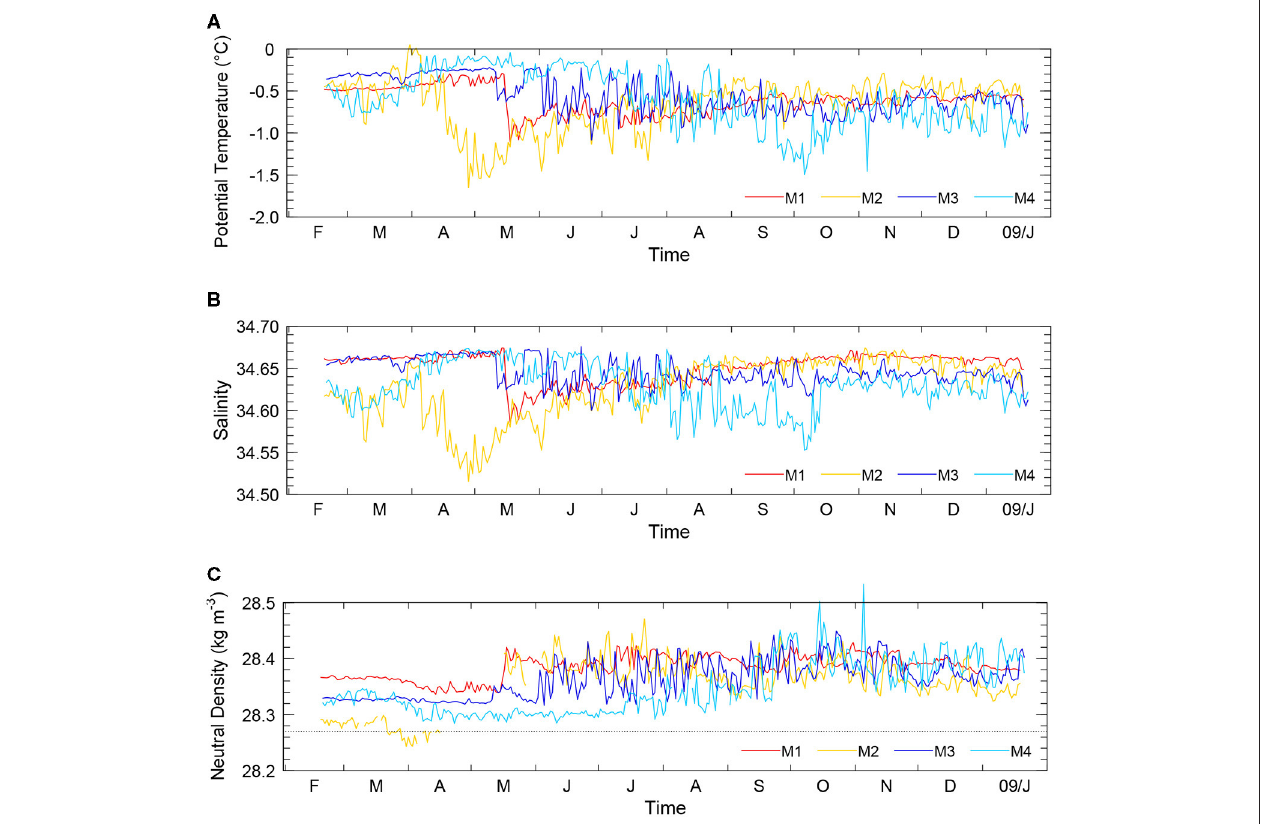
FIGURE 6 | Time series of (A) potential temperature, (B) salinity, (C) and γ n obtained by the deepest conductivity-temperature (CT) sensors at moorings M1 (red), M2 (orange), M3 (blue), and M4 (light blue). In (C) , lines are not drawn in the period when the uncertainty of γ n exceeds 0.03 kg m − 3 . The horizontal dotted line in (C) indicates γ n = 28.27 kg m − 3